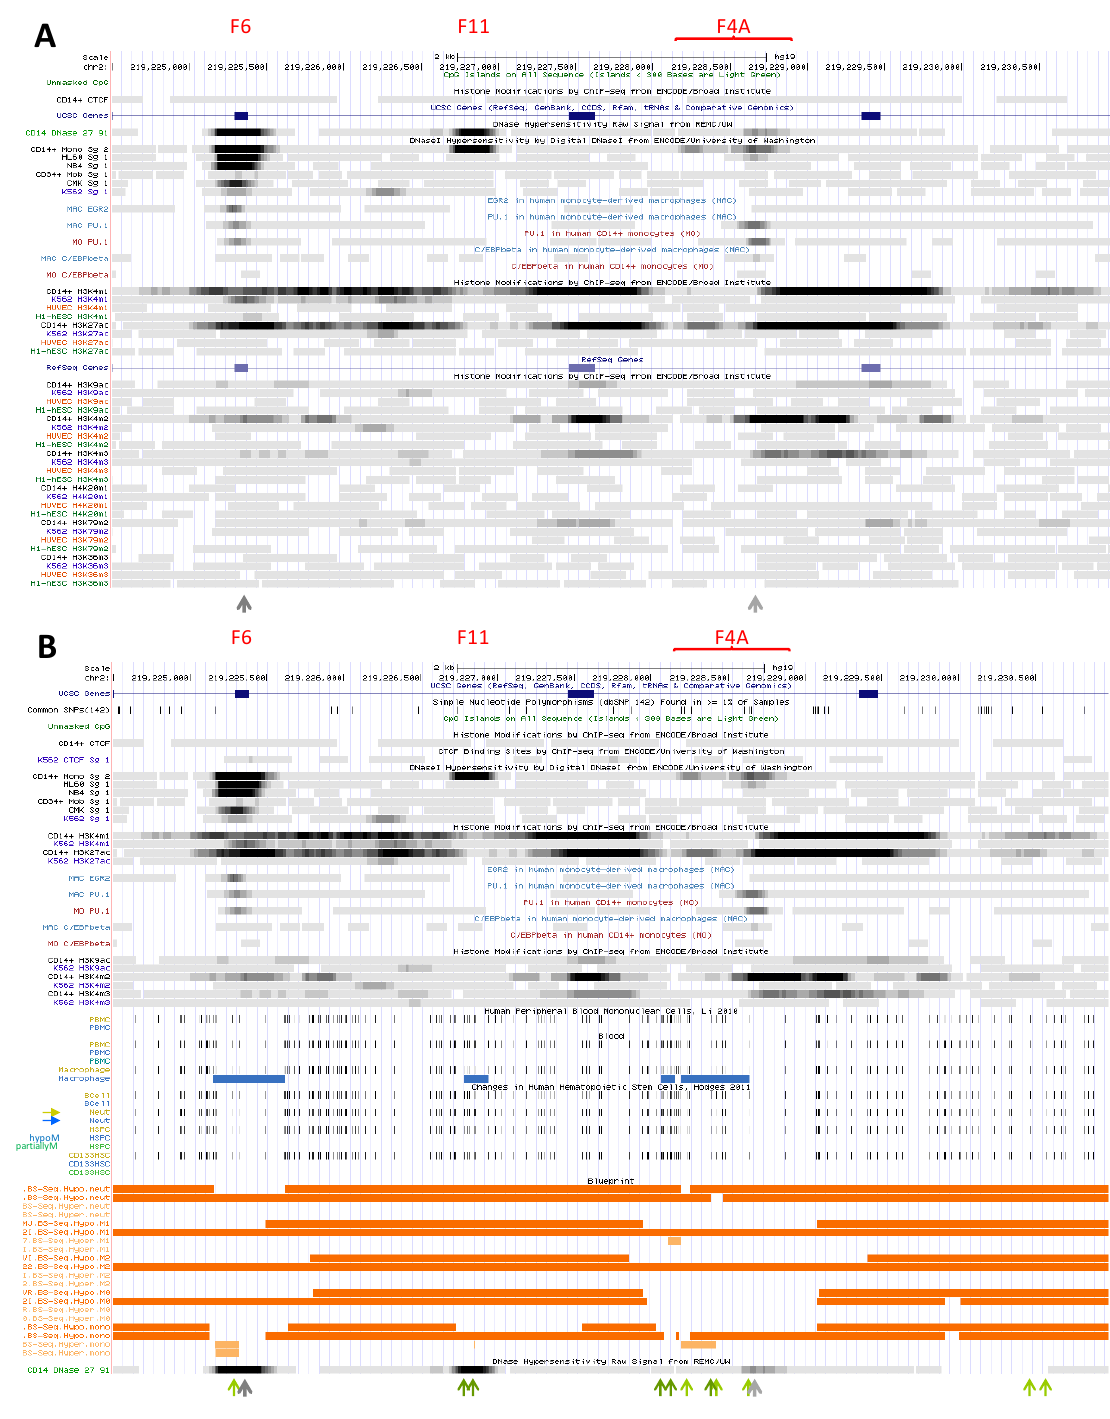
Figure 4. Epigenetic modifications at NRAMP1 locus region i, encompassing Dnase1 footprints F6, F11 and F4A (described in text Sections 2.3.1.1, 2.3.1.2 and 2.3.2.1, respectively). ( A ), ( B ) same as Figure